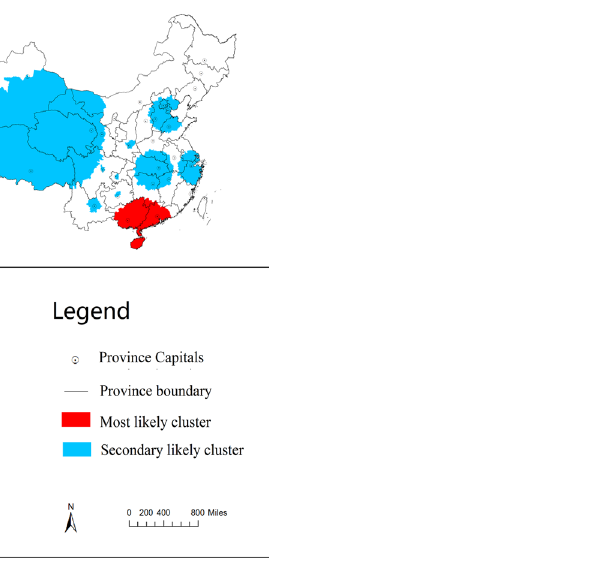
Fig 6. Spatiotemporal clusters of HFMD in mainland China, 2008 – 2012(A-E).